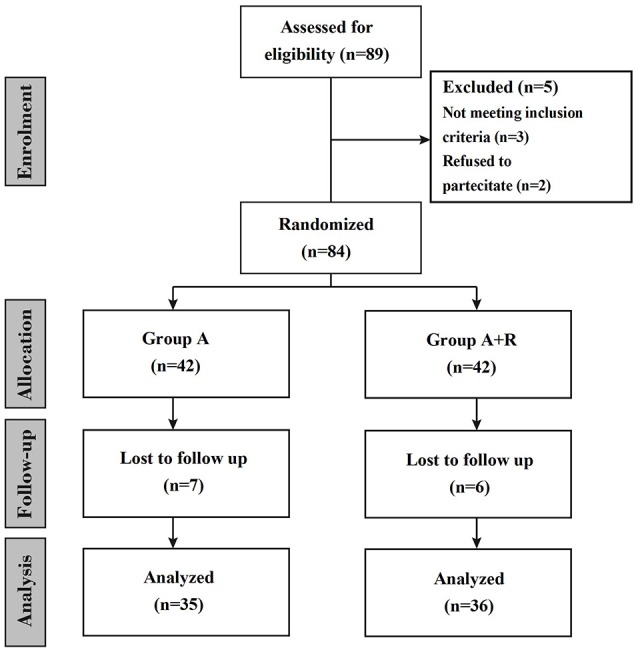
Flow chart of the study.